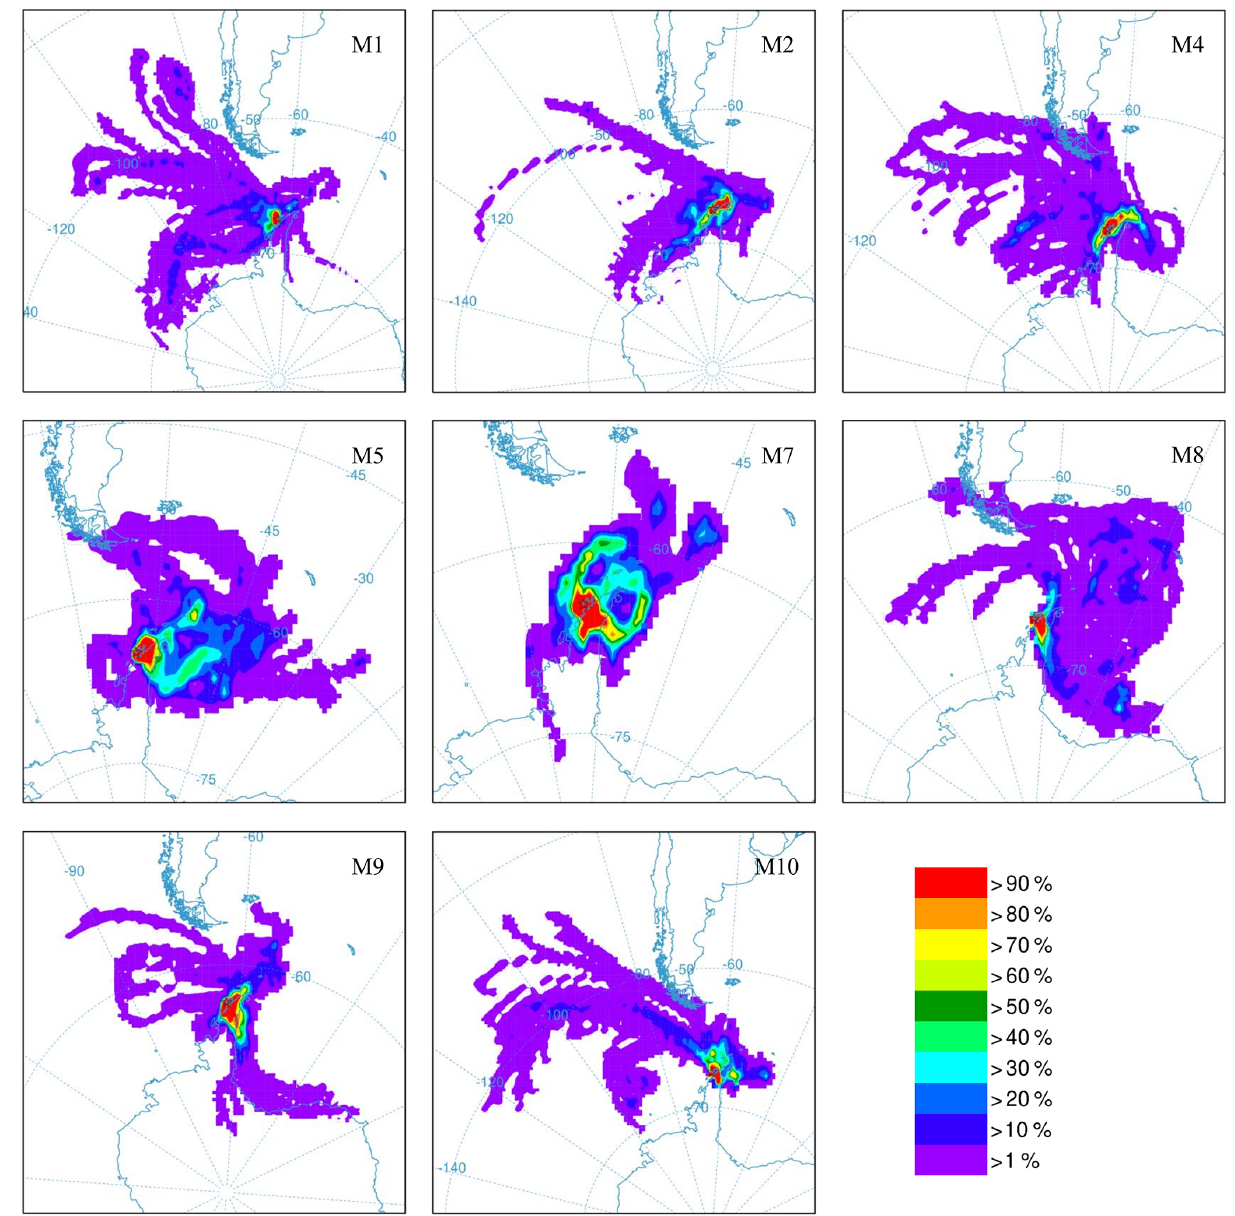
Figure 5. Frequencies of 72h air mass back trajectories for samples collected at Palmer Station: M1 (19–26 November 2016),